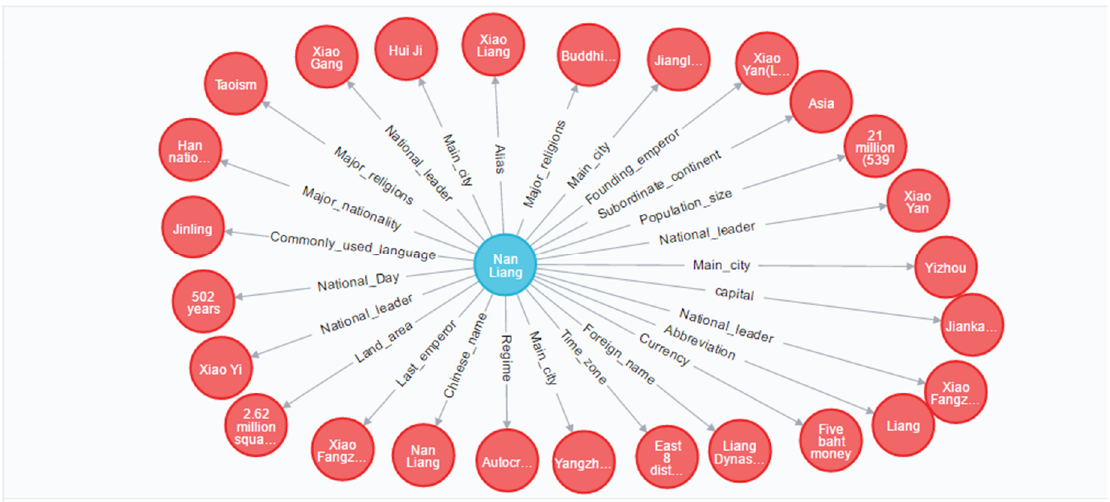
Figure 13. Chinese ancient history and culture knowledge graph query module. The blue circle is entity 1 and the red circle is entity 2. The text on the arrow indicates the relationship between the two. 2.